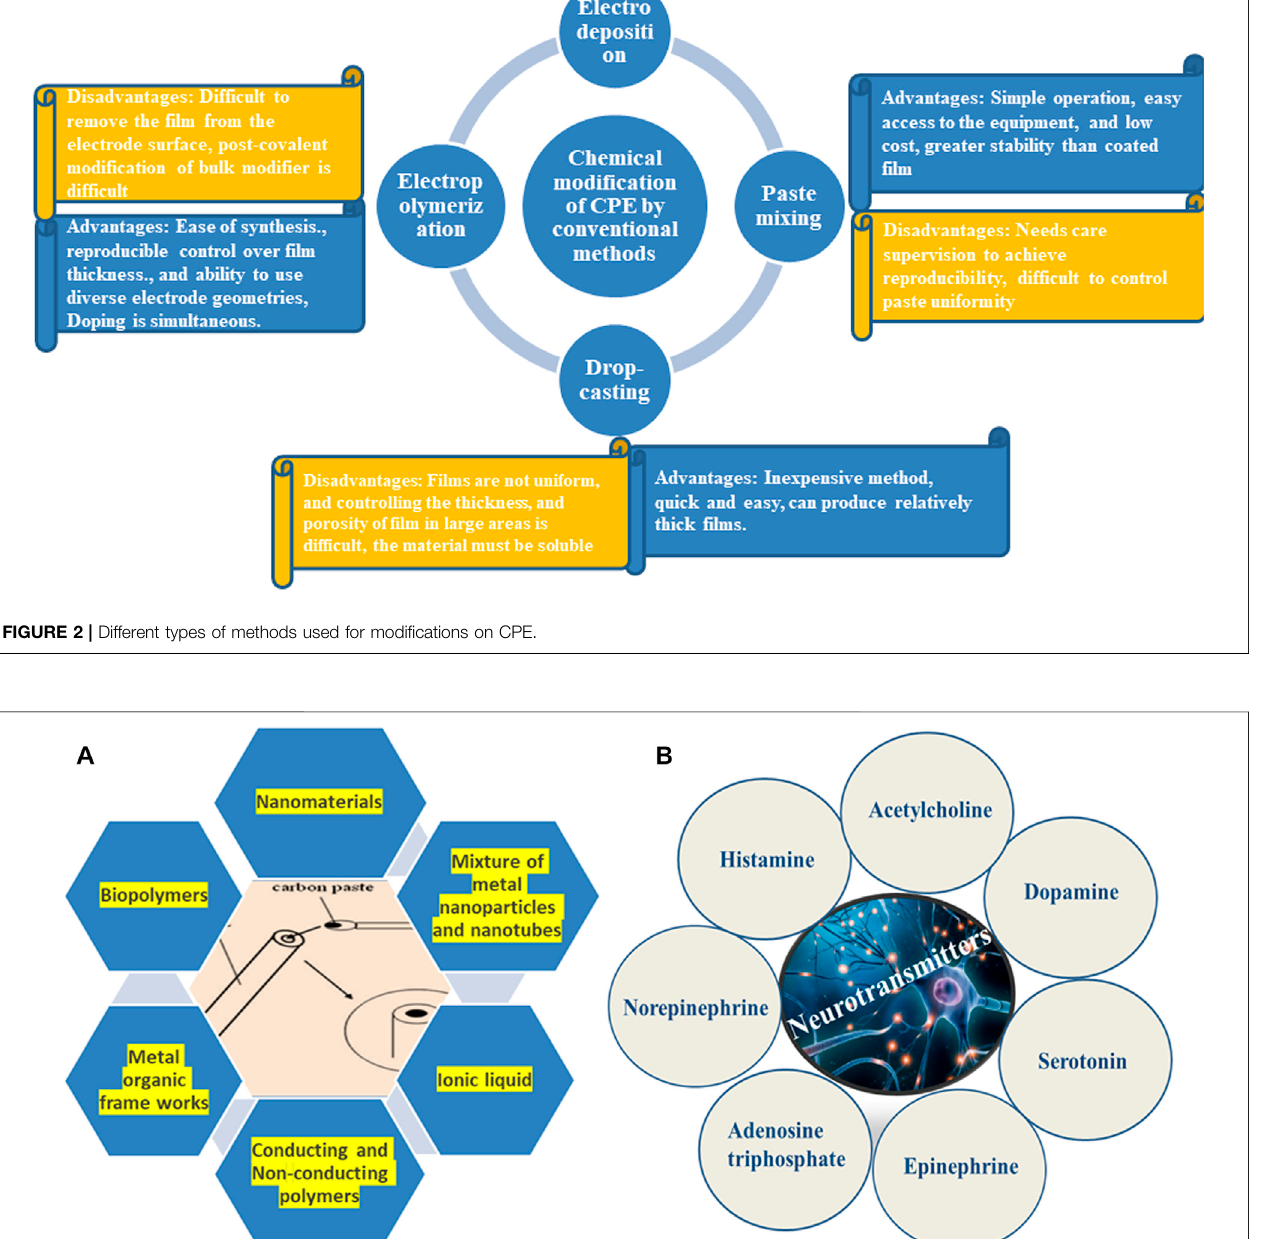
Frontiers in Sensors |